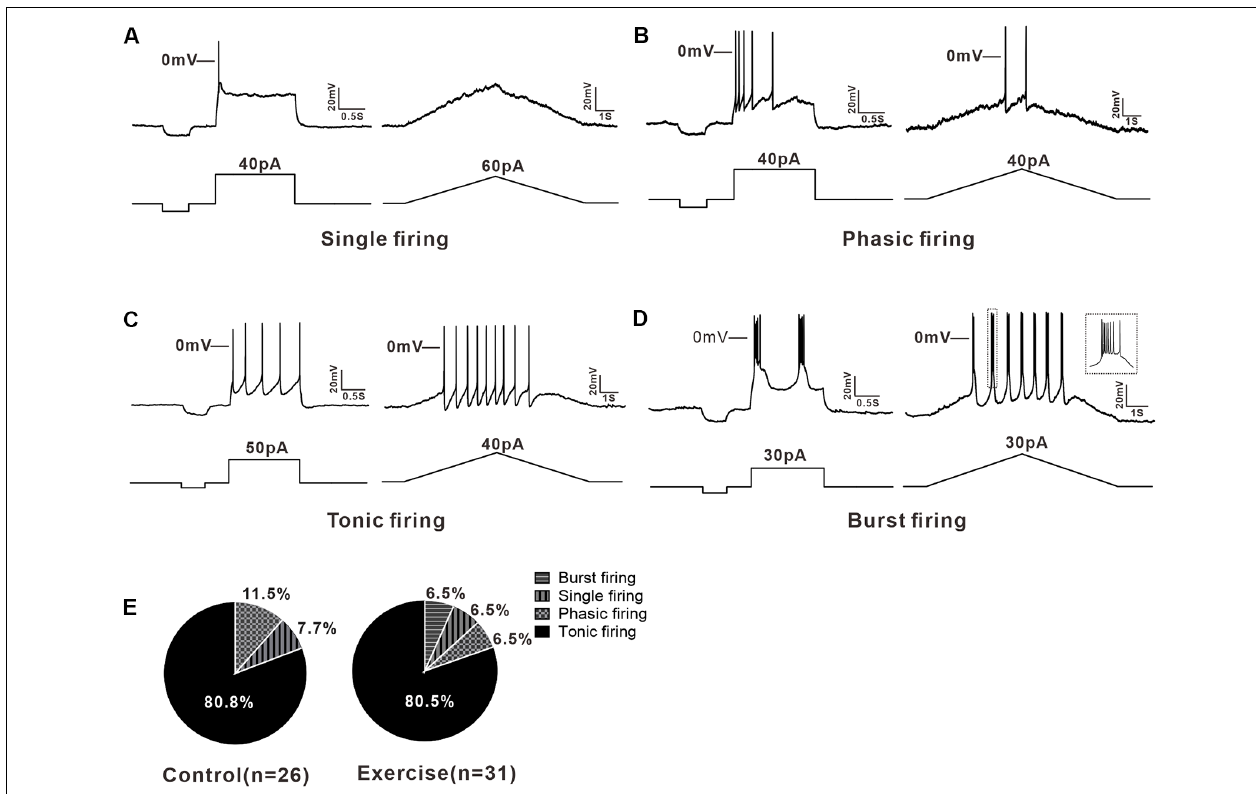
FIGURE 2 | Multiple firing patterns of 5-HT neurons in the DRN. (A) A typical example of single firing neuron, the injected currents (step or ramp) elicited only one action potential (AP). (B) Step current evoked a brief firing in phasic firing type neuron. (C) The tonic firing was evoked by the injected currents (step or ramp) in a tonic firing type neuron. (D) Burst firing, a special tonic firing, was elicited by the injected step or ramp currents. (E) The proportion of each type of neuron in the control and exercise group. A chi-square test showed no significant group difference in proportion of firing patterns ( χ 2 = 0.711, df = 2, p = 0.866).